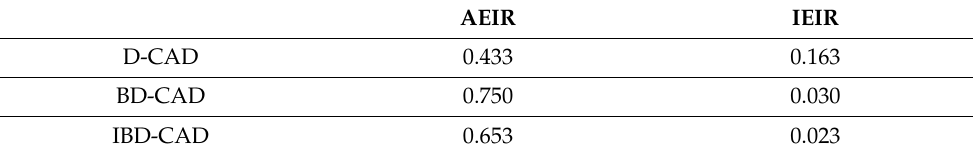
Table 4. Summary of simulation results from different CADs with seven runs